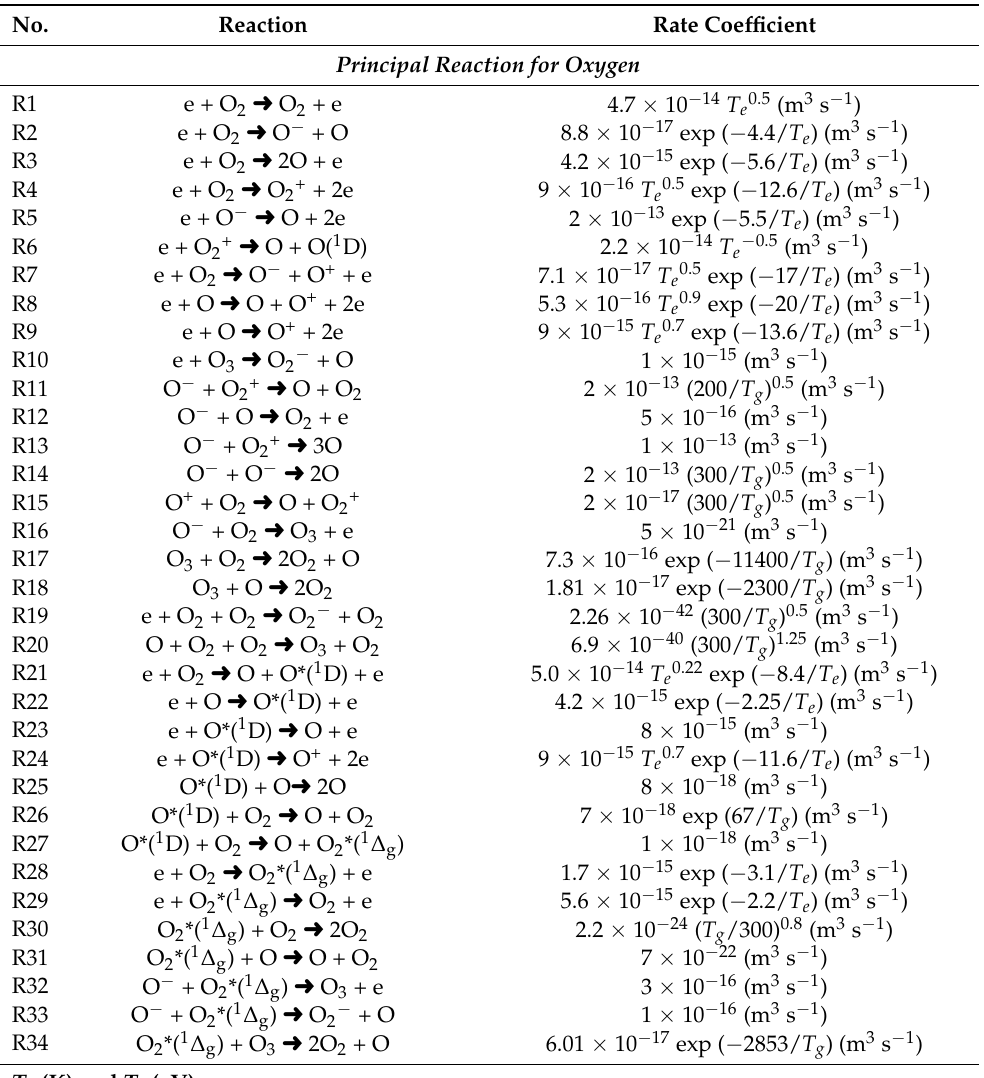
* Excited state of atoms. Table 2. List of reactions for Oxygen in Ar/O 2